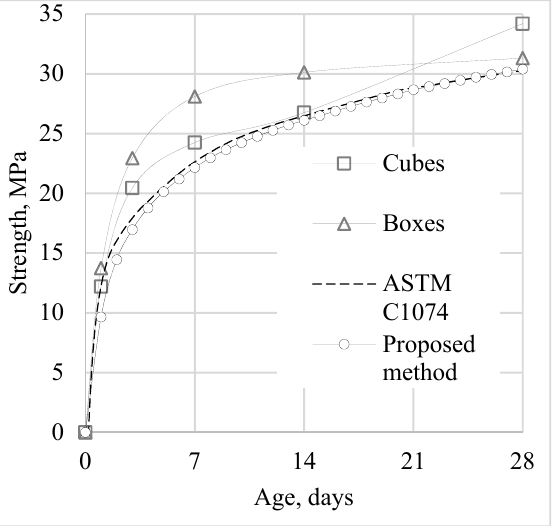
Figure 10. Summary results of concrete strength determined by various methods.